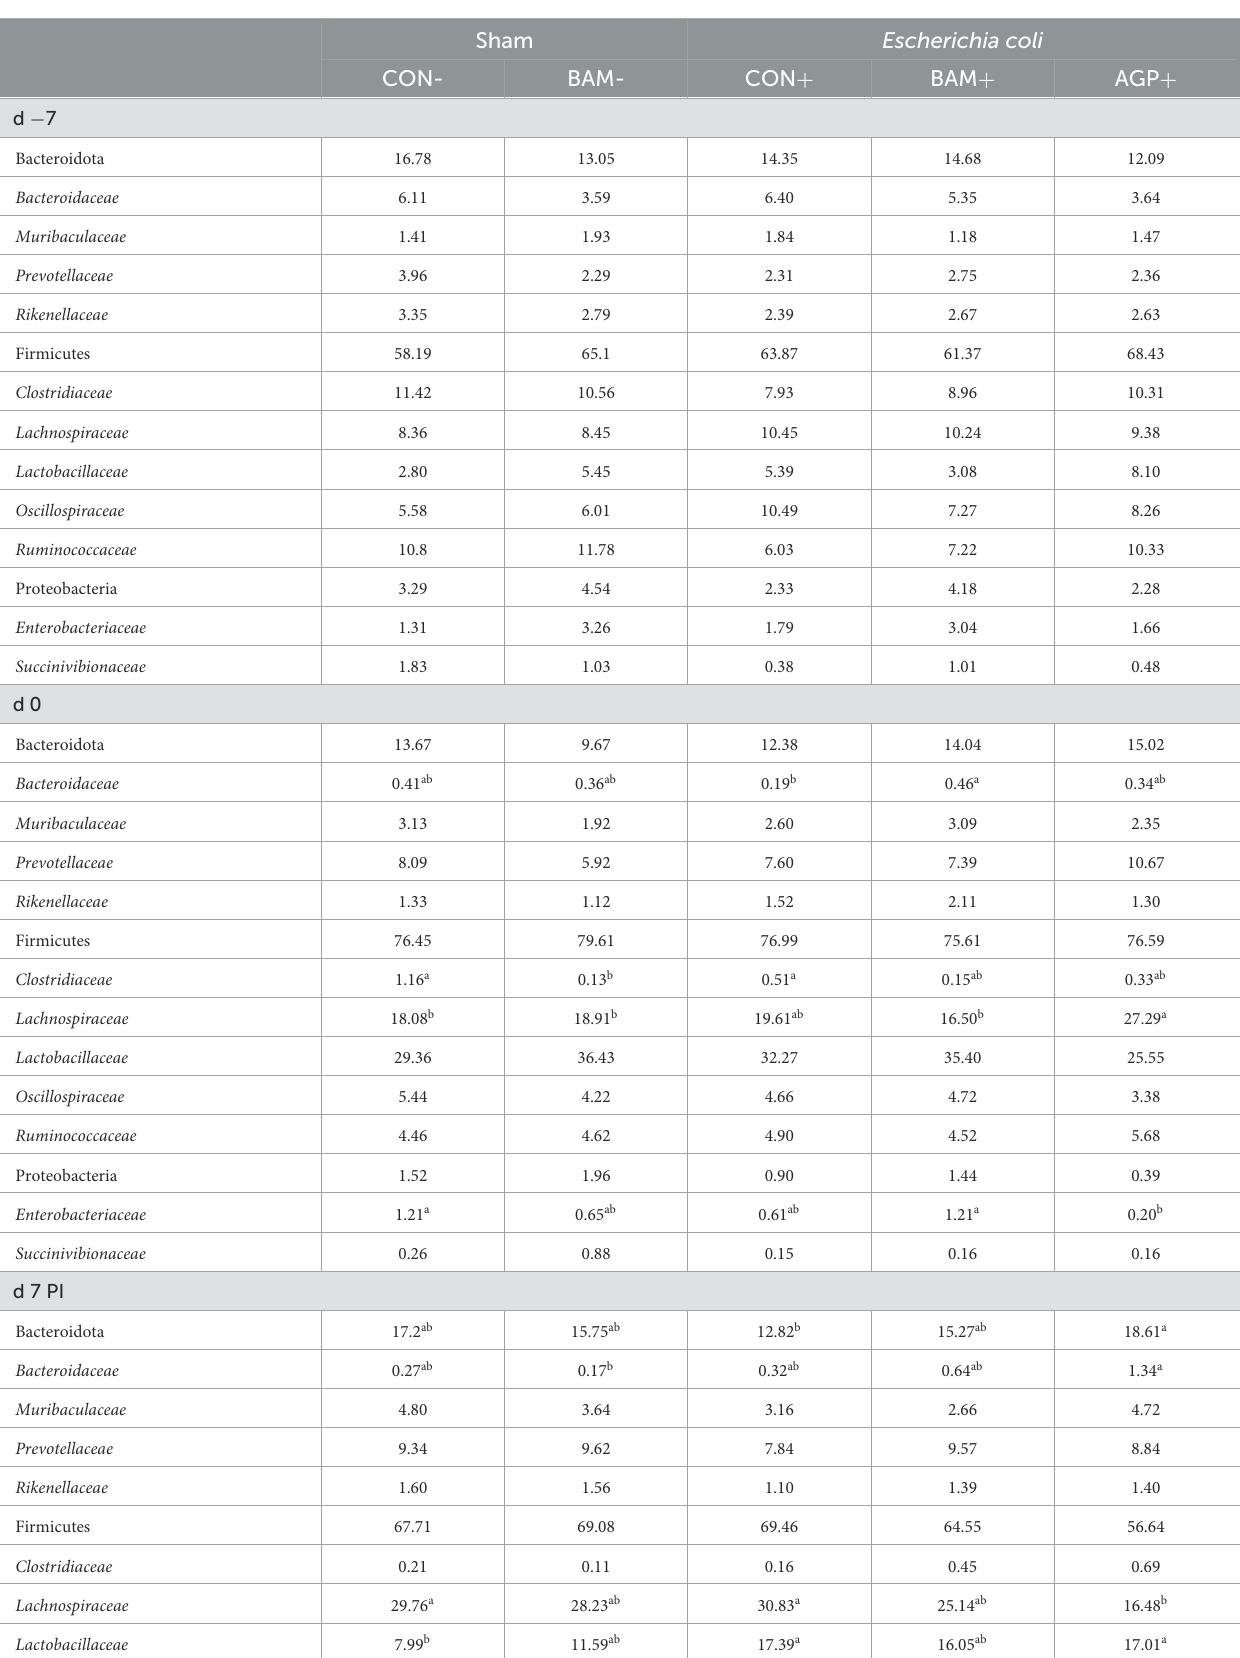
TABLE 4 Relative abundance (%) of Bacteroidota, Firmicutes, and Proteobacteria and their top families in feces of weaned pigs a fed control (CON) diet or diets supplemented with Bacillus amyloliquefaciens (BAM) or antibiotics (AGP). Sham Escherichia